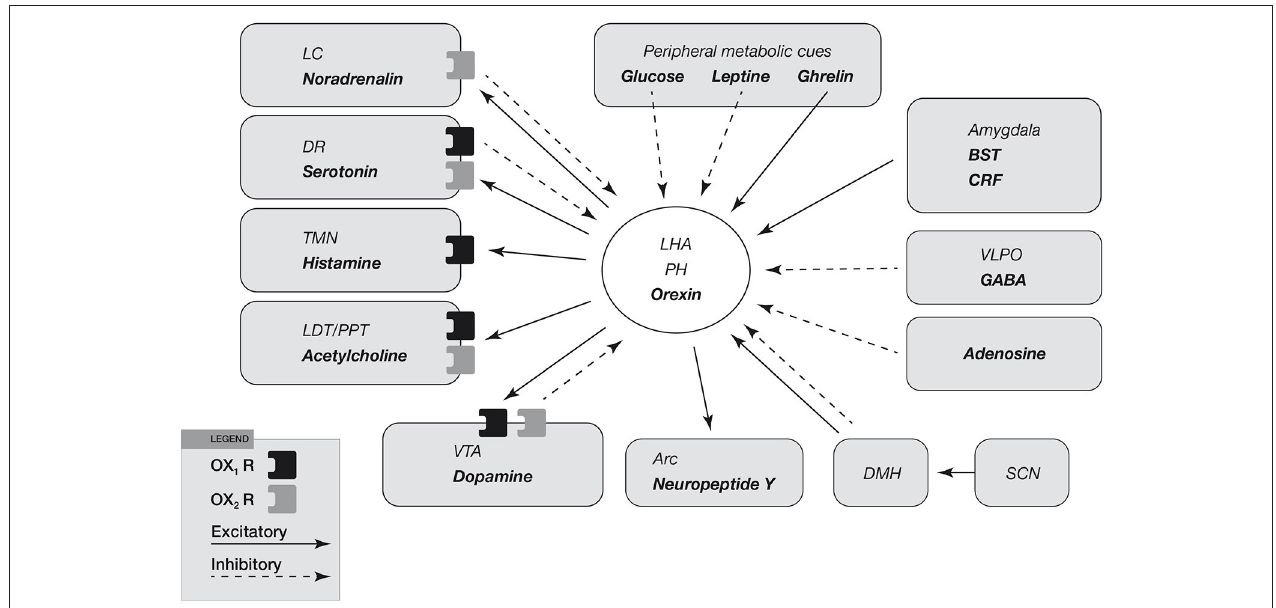
FIGURE 1 | Schematic representation of orexin system. Orexin A and orexin B are derived from a common precursor peptide, prepro-orexin. The actions of orexins are mediated via two G protein-coupled receptors named orexin-1 (OX 1 R) and orexin-2 (OX 2 R) receptors. OX 1 R is selective for orexin A, whereas OX 2 R is a non-selective receptor for both orexin A and orexin B. OX 1 R is coupled exclusively to the Gqsubclass of heterotrimeric G proteins, whereas OX 2 R couples to Gi/oand/or Gq.